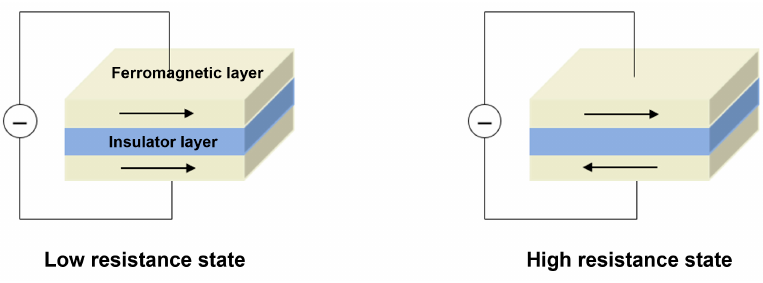
Figure 9. Working principles of TMR sensor.